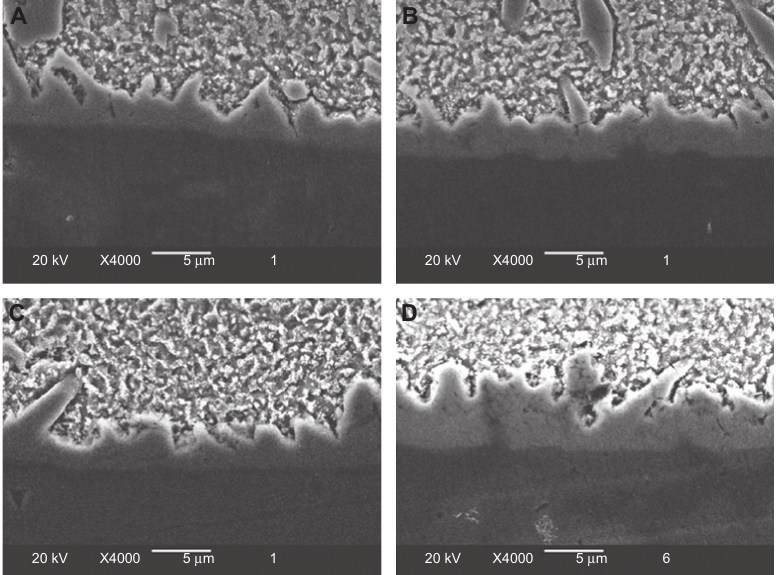
Figure 7 SEM micrographs of the interfacial IMC formed between the SAC305 – 0.1 vol% MWCNT solder and the copper substrate at differ- ent aging temperature for 500 h: (A) 230 ° C, (B) 250 ° C, (C) 260 ° C, and (D) 270 ° C.